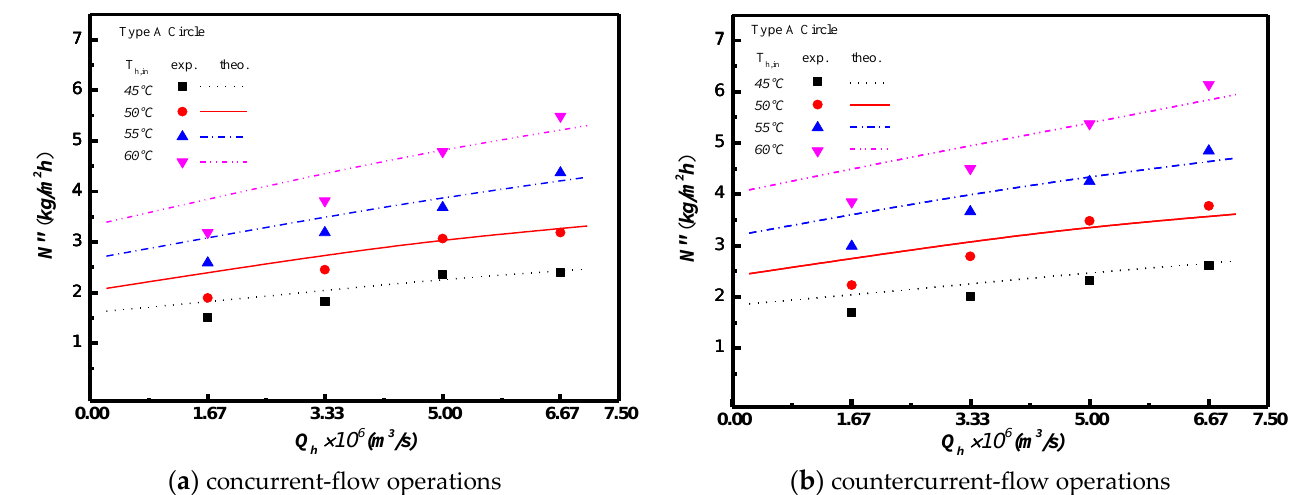
Figure 11. Effects of saline water flow rate and flow pattern on permeate flux for Type A circle turbulence promoter.